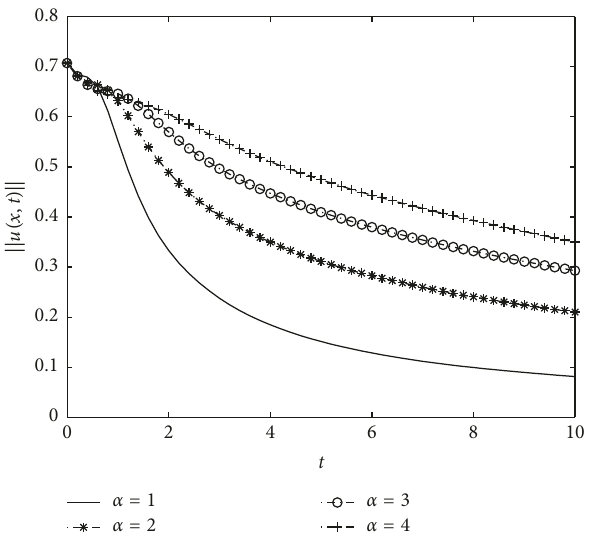
Figure 2: The L 2 -norm of u ( x,t ) , ‖ u ( x, t )‖ , over time for various values of α when applying the first nonlinear adaptive controller μ � 0 . 001, c � 1, c � 0 . 0005, r � 0 . 2, r � 0 . 2, and u ( x ) � sin ( π x ) 1 2 1 2 0